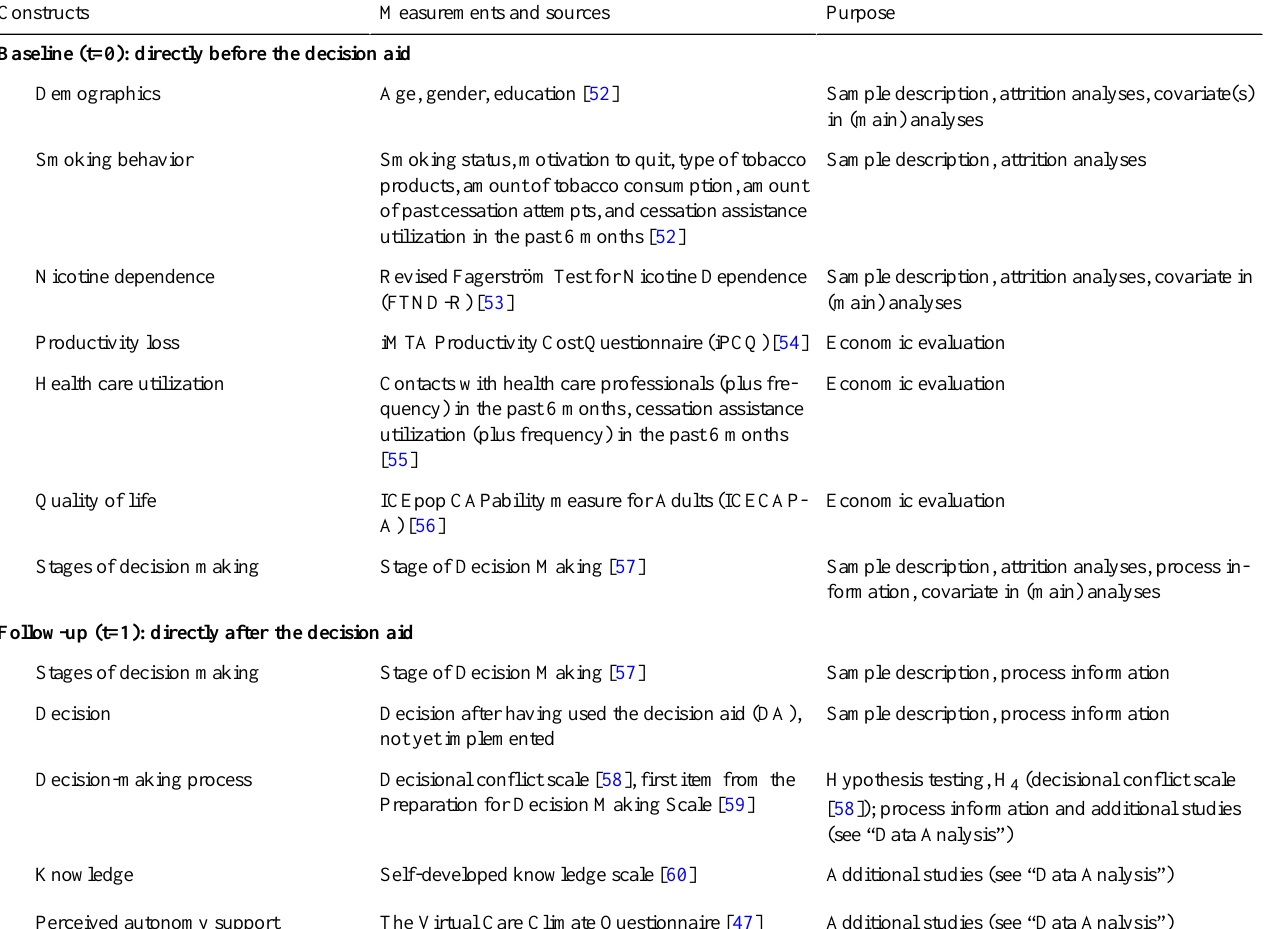
Table 3. Overview of included constructs, measurements, and sources. PurposeMeasurements and